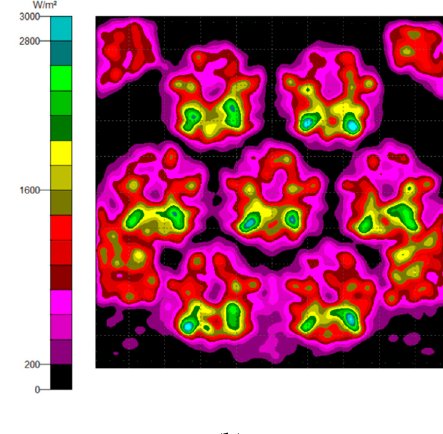
Figure 24. The misalignment light-guiding unit array. Figure 25. The misalignment light-guiding unit array. Figure 25. The misalignment light-guiding unit array.